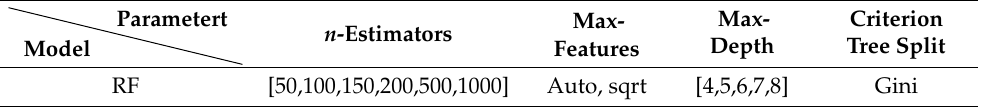
Table 6. Optimal parameter search for random forests using GridSearchCV.